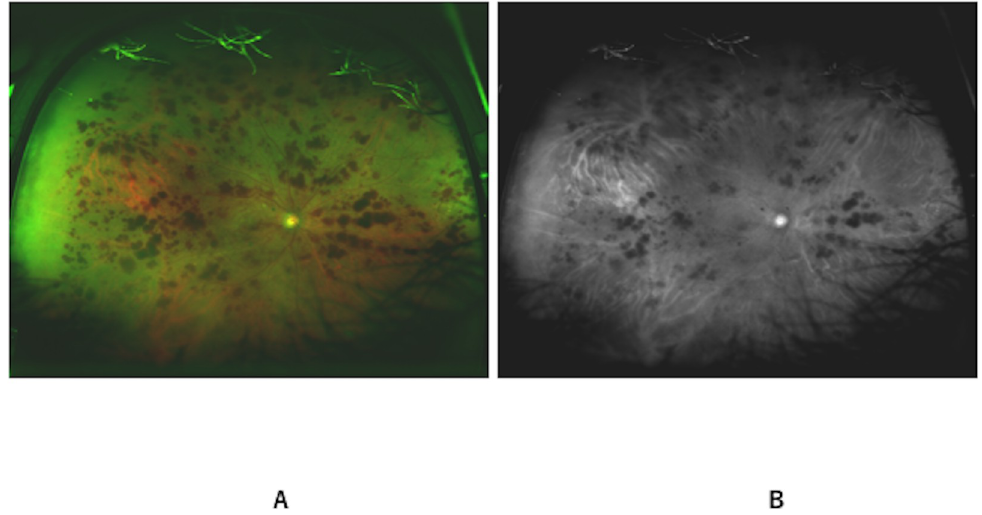
Fig 1. Representative image in CRVO. Representative ultra-widefield images of ischemic CRVO. Color fundus image (A) and red channel image (B) were used for the analysis. CRVO: Central retinal vein occlusion.